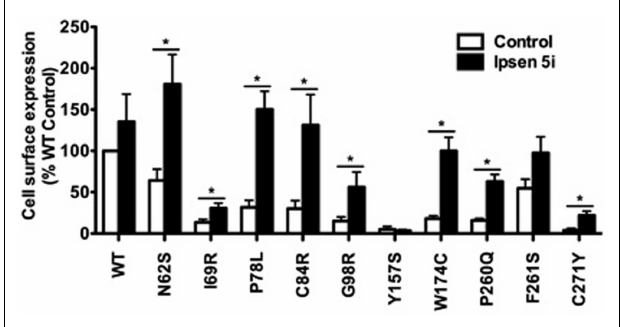
FIGURE 4 | Ipsen 5i rescued the cell surface expression of intracellularly retained mutant MC4Rs in Neuro2a cells . Neuro2a cells transiently expressingWT or mutant MC4Rs were treated with 10 − 6 M Ipsen 5i. Results are shown as mean ± SEM of at least three independent experiments. See the legend to Figure 3 for